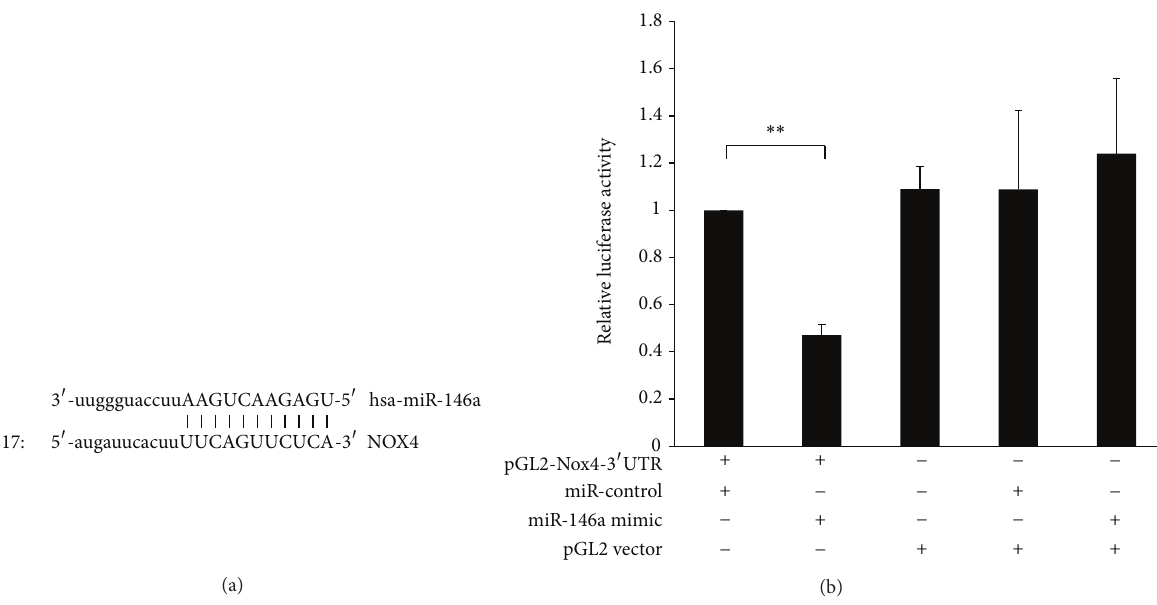
Figure 3: Nox4 was identified as a target of miR-146a. (a) Bioinformatic miR target analysis identified homology between miR-146a and the 3 󸀠 -UTR of the human Nox4 mRNA, indicating potential regulation of Nox4 by miR-146a. (b) A luciferase reporter assay showed that the miR-146a mimic could downregulate relative luciferase activity of pGL2-Nox4-3 󸀠 -UTR compared with the miR-control. The bars represent the means ± SEM from 6 experiments. ∗∗ 𝑃 < 0.01 , as compared with the miR-control.